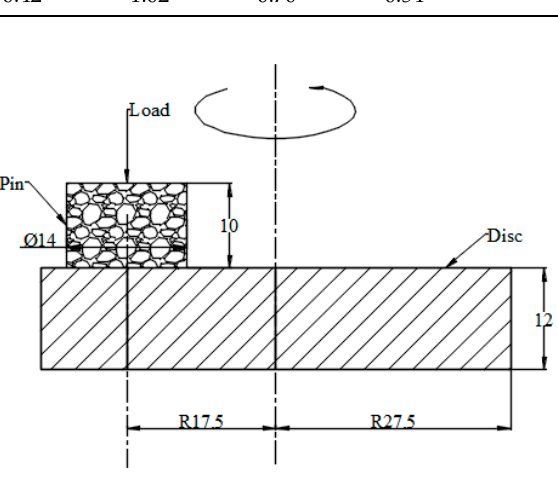
Figure 1. The size of the disc and pin samples.